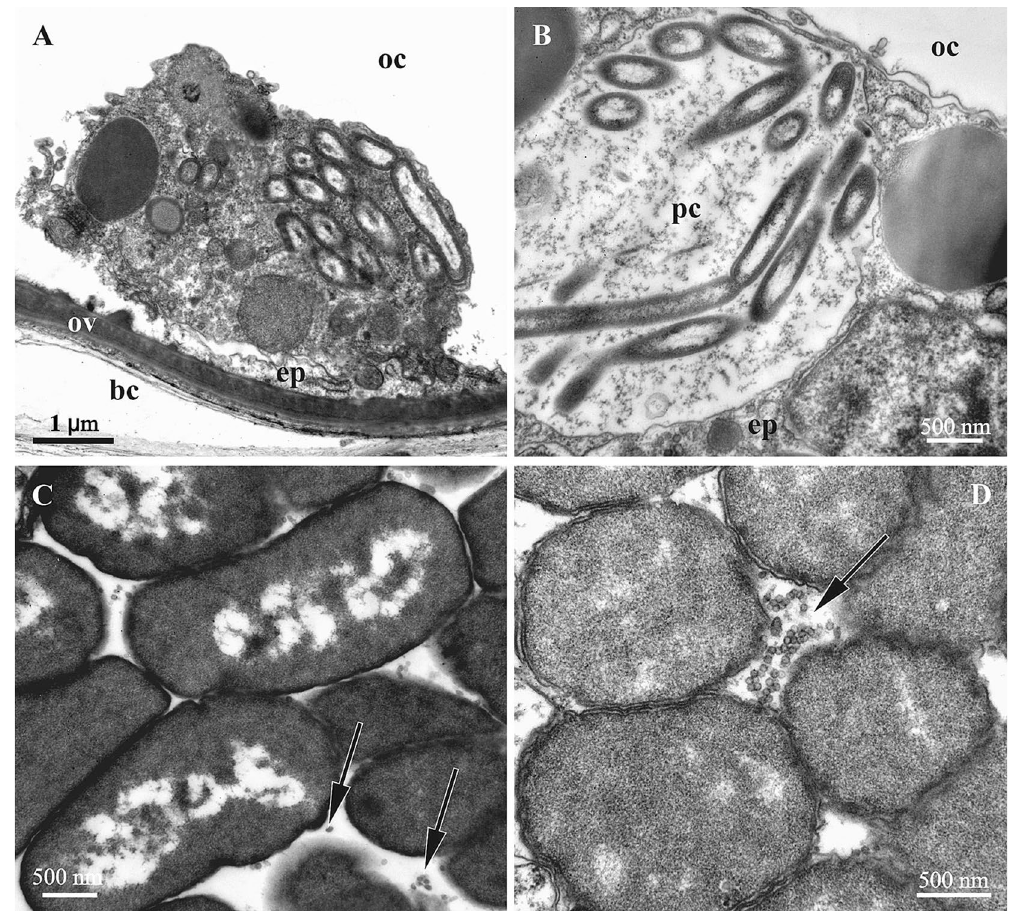
Figure 7. Symbiotic bacteria inside autozooids of Bugula neritina . A , B , intact bacteria of ‘type I’ in the cytoplasm of presumed coelomocyte ( A ) and peritoneal cell ( B ) of the body wall (ooecial vesicle). ( C , D ) bacteria in the funicular bodies: ‘type II’ ( C ) and ‘type III’ ( D ) with VLP visible in between bacterial cells (arrows). TEM. Abbreviations: bc, incubation space of brood chamber; ep, epithelial cell; oc, coelom of ooecial vesicle; ov, wall of ooecial vesicle; pc, peritoneal